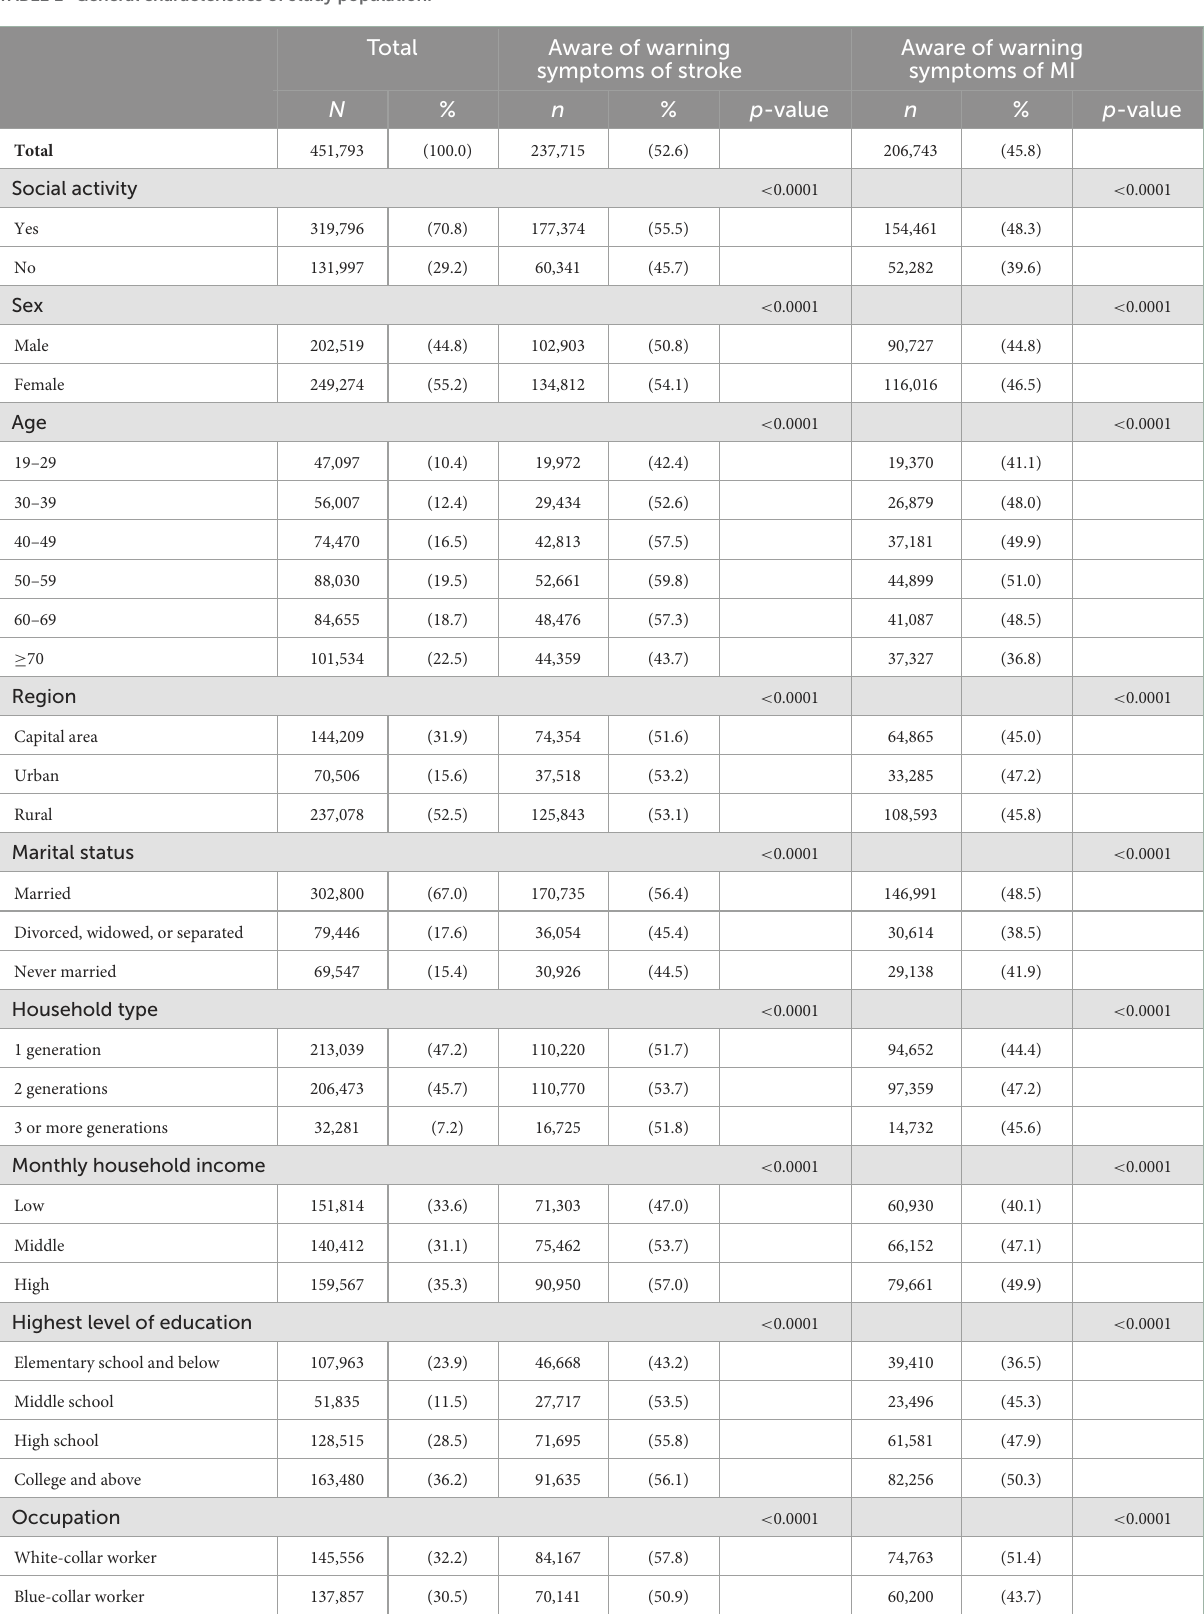
TABLE 1 General characteristics of study